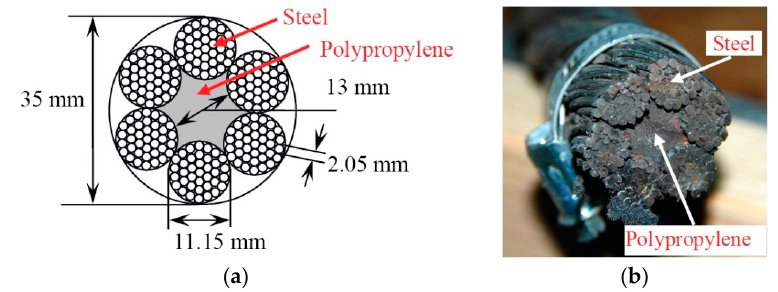
Figure 1. The rope under investigation: ( a ) schematic view; and ( b ) photo of the cross-section of the multi-bundle and multi-wire twisted rope.